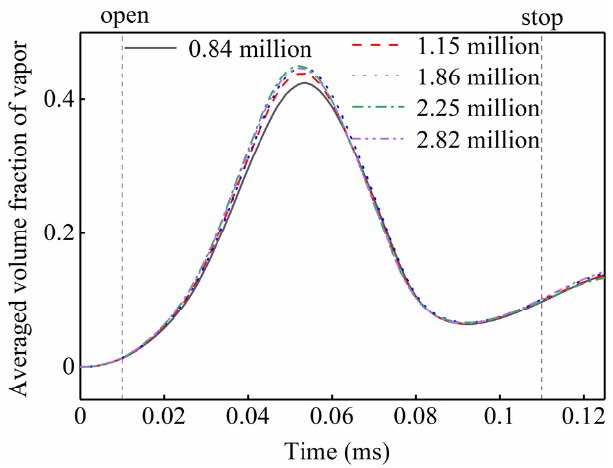
Figure 2. Comparison of average volume fraction values of vapor.